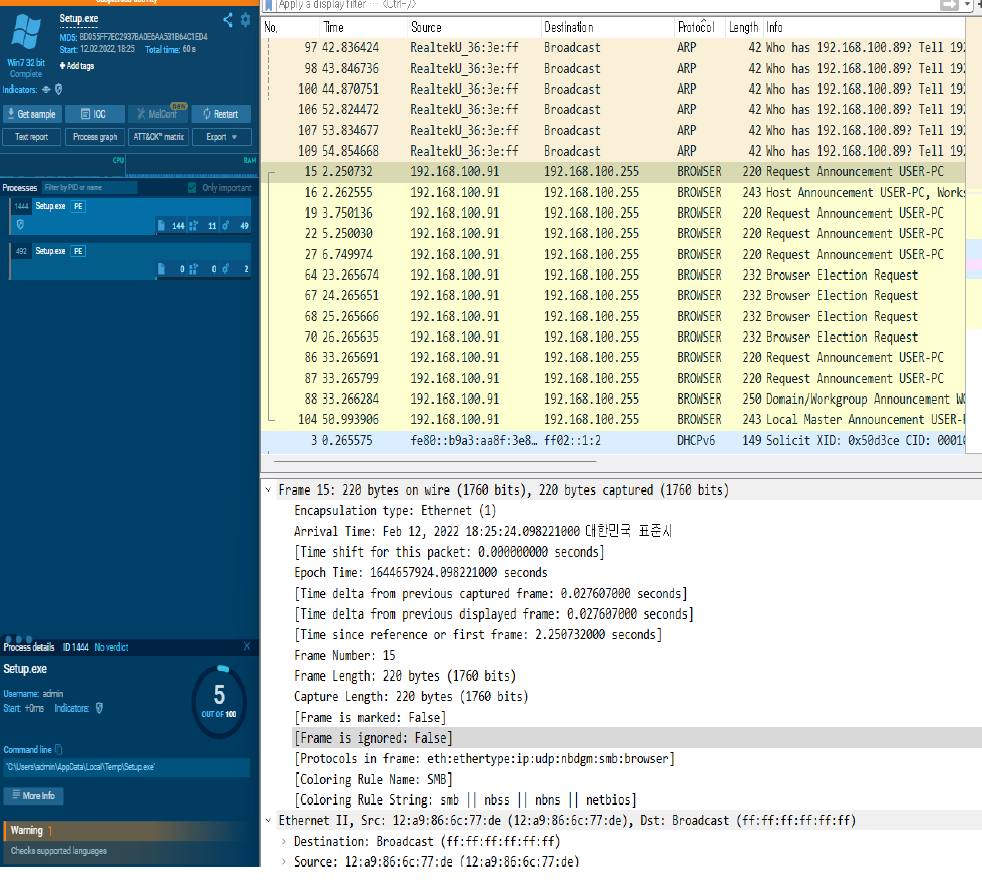
Figure 13. setup.exe malicious file packet analysis result. Figure 13. Setup.exe malicious file packet analysis